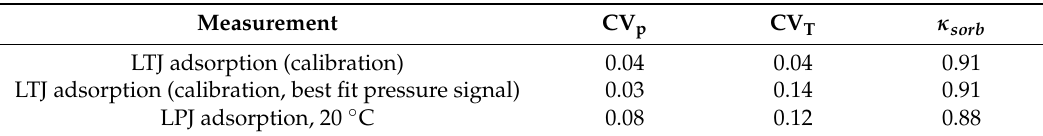
Table 11. Coefficient of variance for the simulation of an IR-LPJ measurement and an IR-LTJ measurement of sample